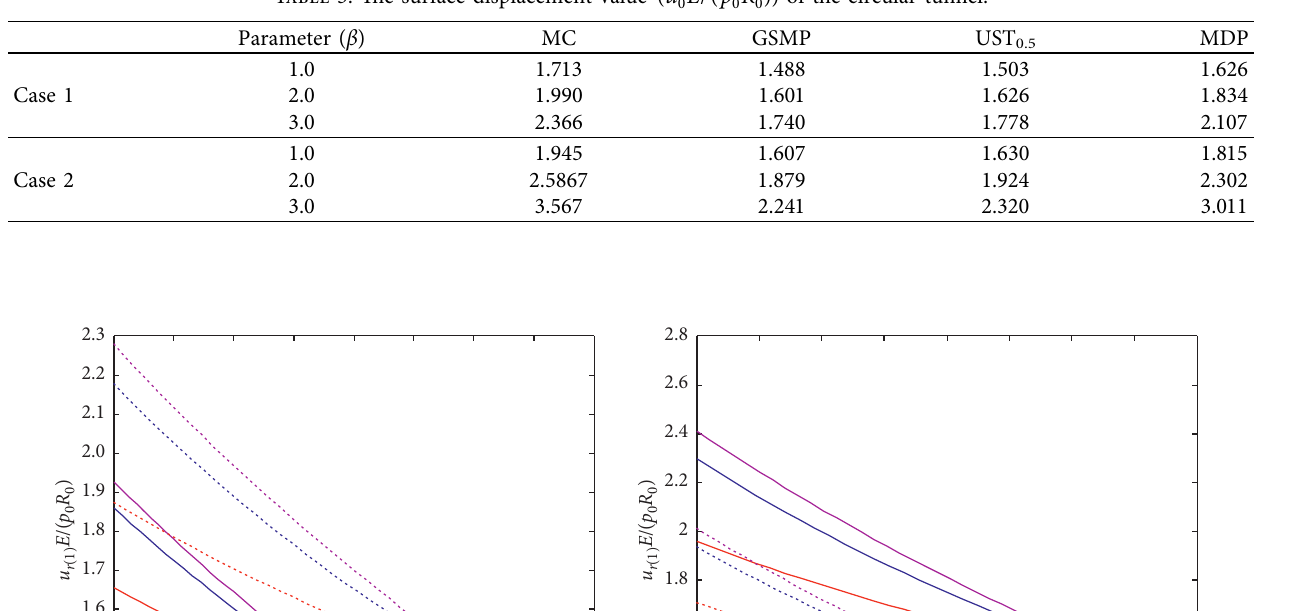
Figure 9: The effect of dilation coefficient on the surface displacement. Table 5: The surface displacement value ( u